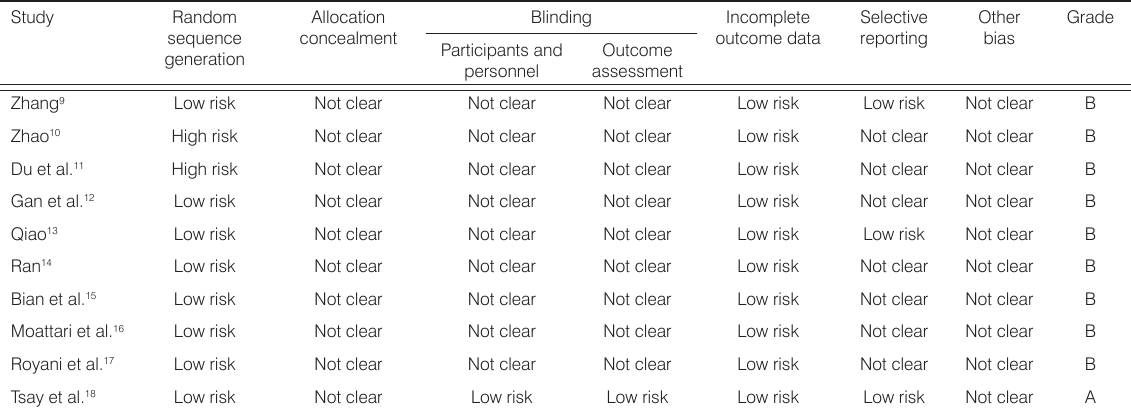
Table 2. Methodological quality assessment of included studies.